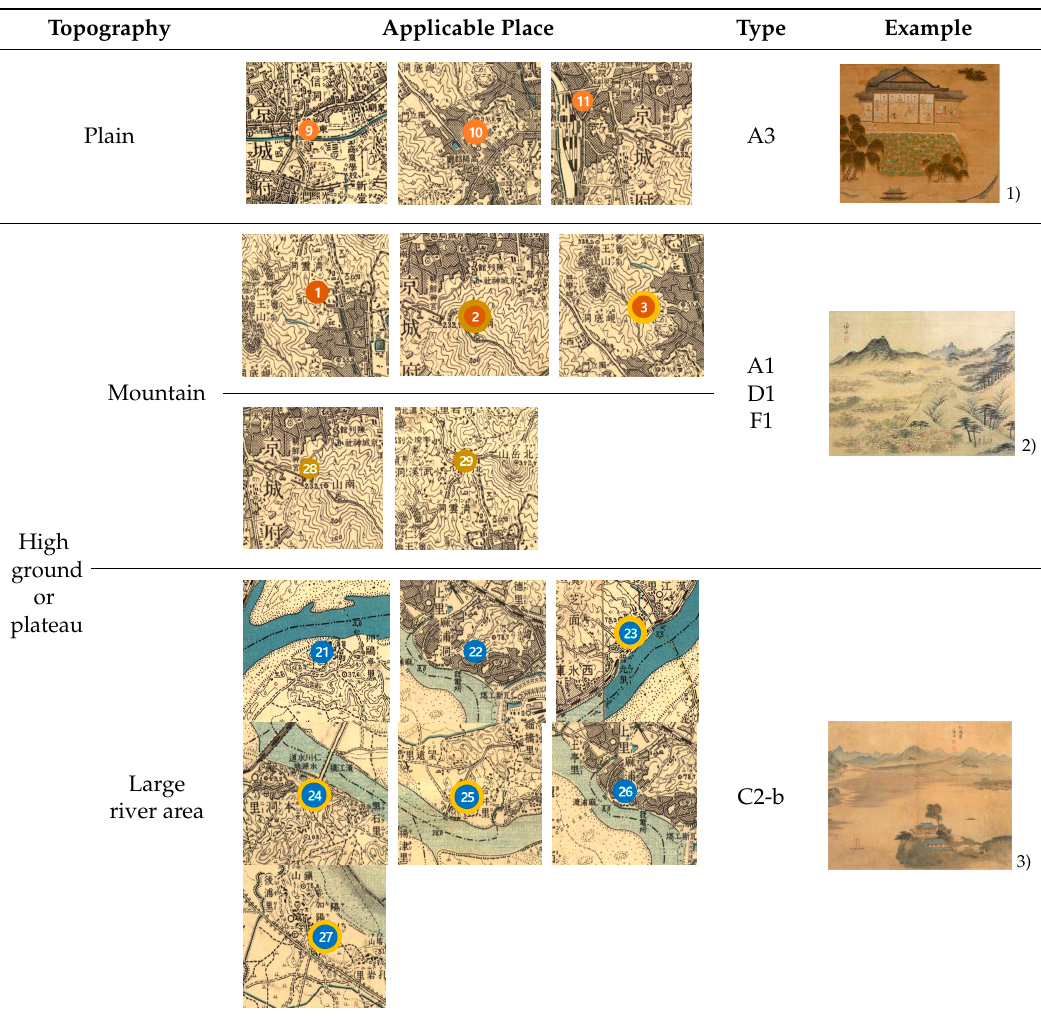
Table 5. The topographical categories and types of enjoyment for the noted natural places.